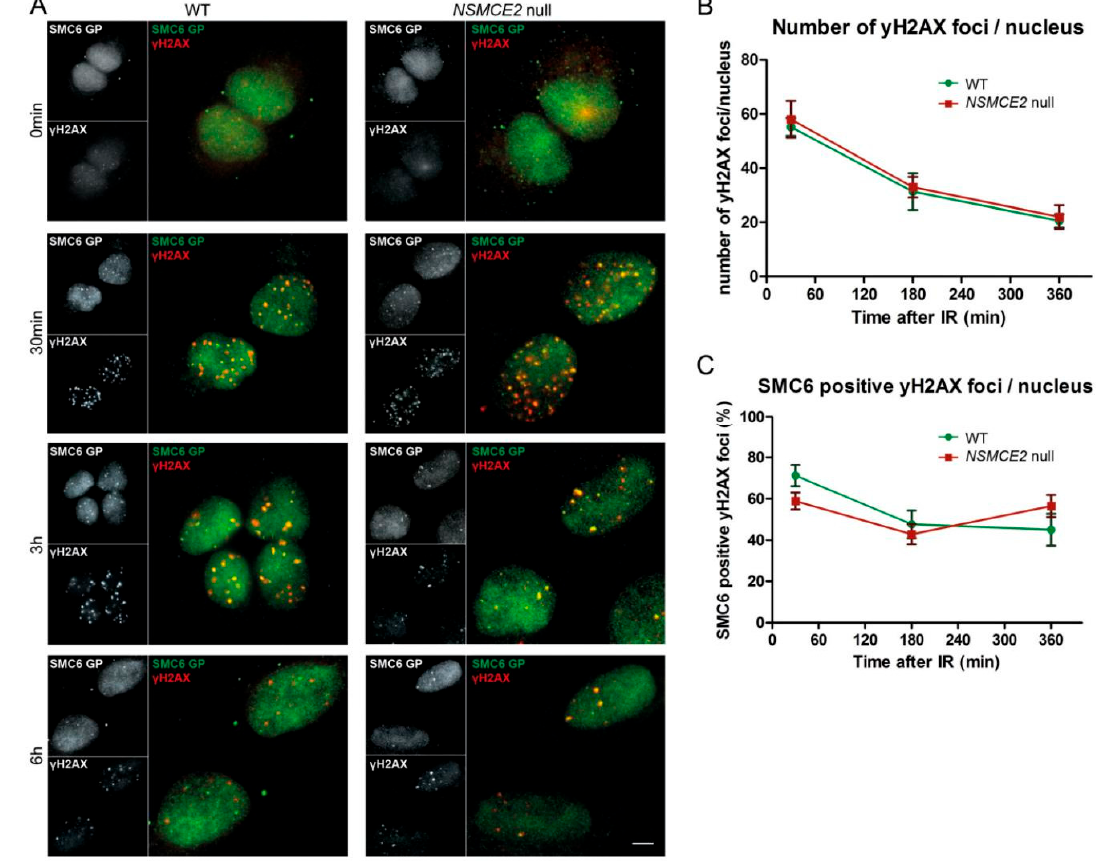
Figure 3. Ionizing irradiation (IR)-induced double-strand break (DSB) foci formation in the absence of NSMCE2. ( A ) WT and NSMCE2 null cells were subjected to 1 Gy of IR, fixed at different time points post IR (0 min: immediately after IR) and stained for γ H2AX (a marker for DNA damage, red) and SMC6 (green). SMC6 localized to sites of DNA damage in both WT and NSMCE2 null cells. Bar = 5 µ m; ( B ) Quantification of the average number of γ H2AX foci in each cell. Data are presented as mean ± SEM, n = 3; ( C ) Quantification of the average number of γ H2AX foci that overlap with a SMC6 focus. Data are presented as mean ± SEM, n = 3.